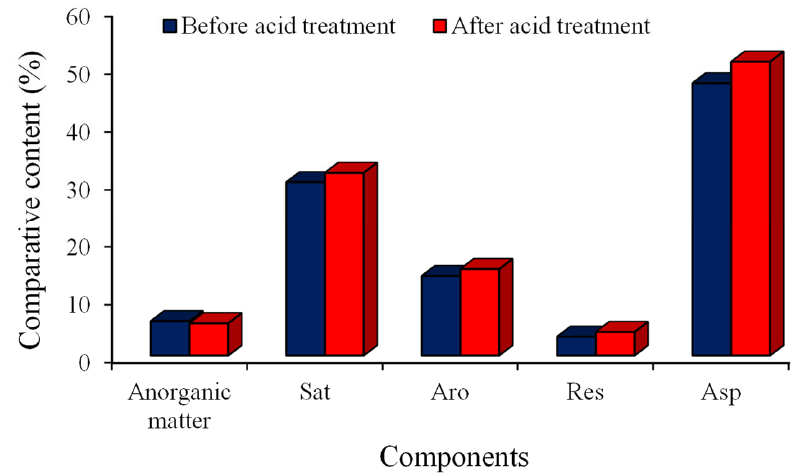
Figure 6. Comparison of the relative content changes in components before and after acidification of the blockage at the wellhead of Well DH231.